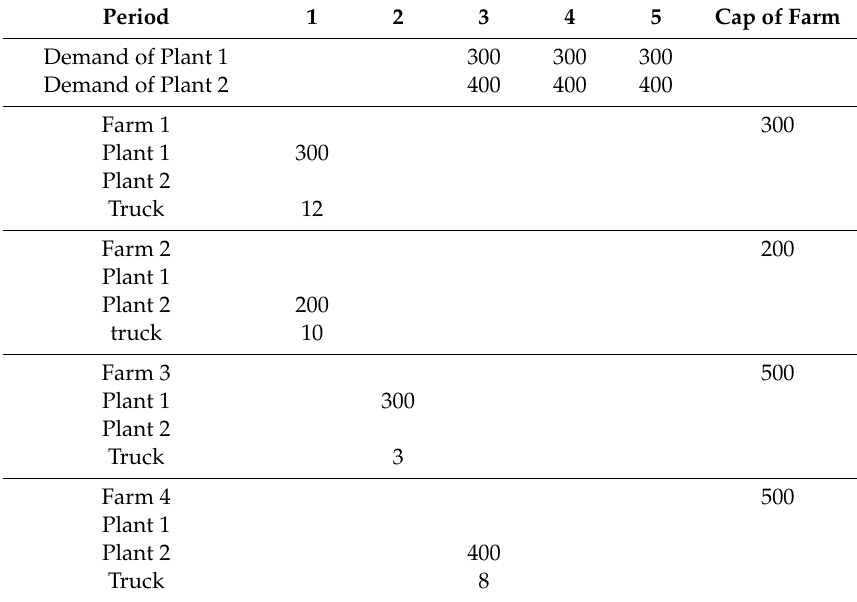
Table 1. Production planning and plant and truck assignment results while using Algorithm 1.